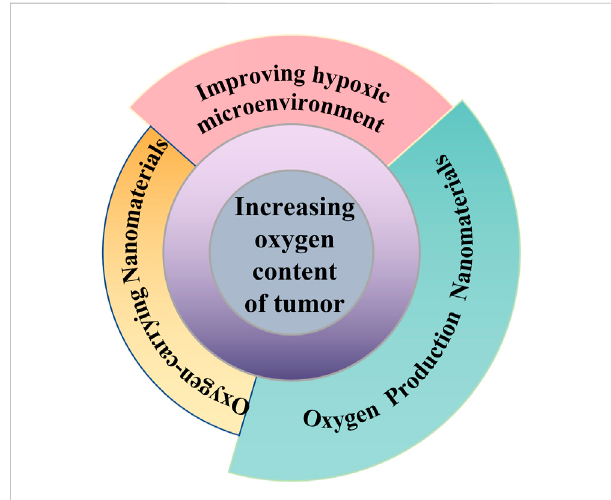
Schematic diagram of increasing oxygen content of